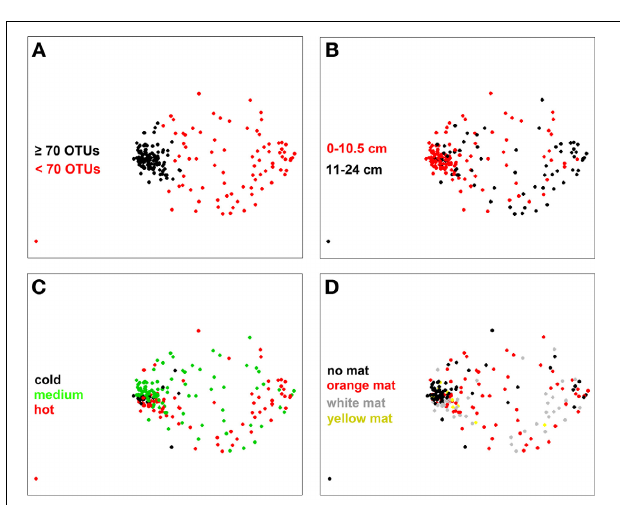
FIGURE 5 | NMDS plot of bacterial community structure based on a Bray-Curtis distance matrix (stress 0.16). Color coding was done according to (A) bacterial OTU number threshold (70 OTUs), (B) sediment depth, (C) subsurface temperature as categories cold ( T < 10 ◦ C), medium (10 ◦ C ≤ T < 40 ◦ C) and hot ( T ≥ 40 ◦ C, T measured in the upper 10cm of sediment), and (D) mat